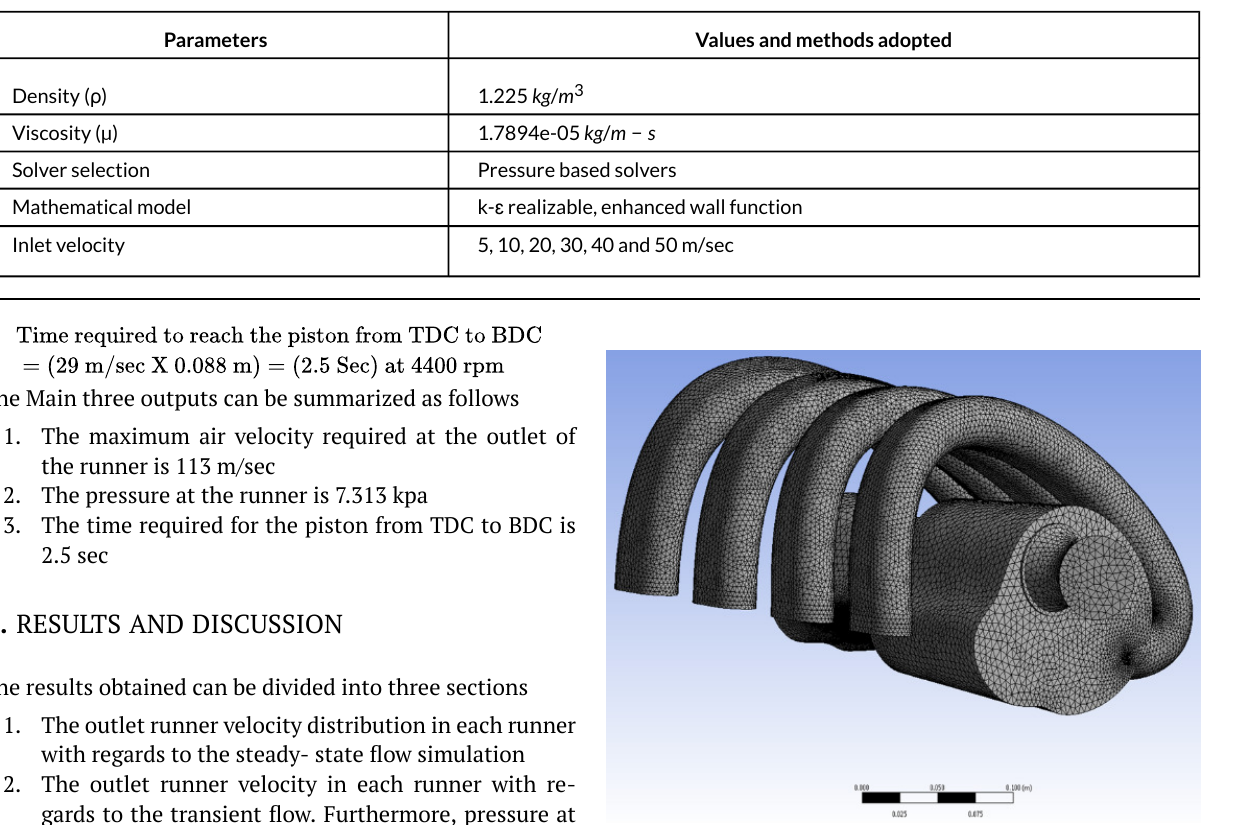
TABLE 2. PARAMETERS AND VALUES